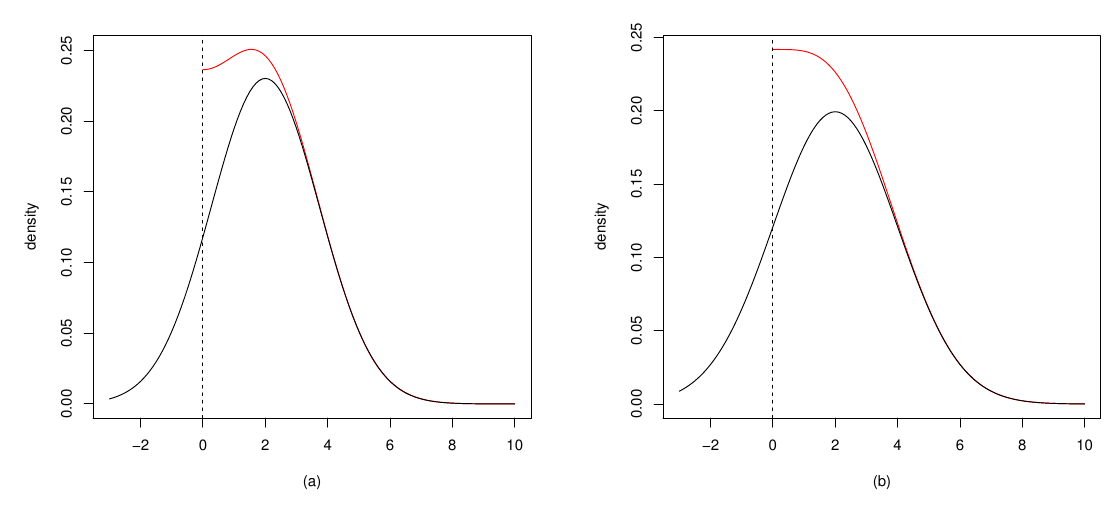
Figure 1. The black line is the density of the N ( µ, σ 2 ) and the red line of the F N ( µ, σ 2 ) . The parameters in the left figure ( a ) are µ = 2 and σ 2 = 3 and in the right figure ( b ) µ = 2 and σ 2 = 4